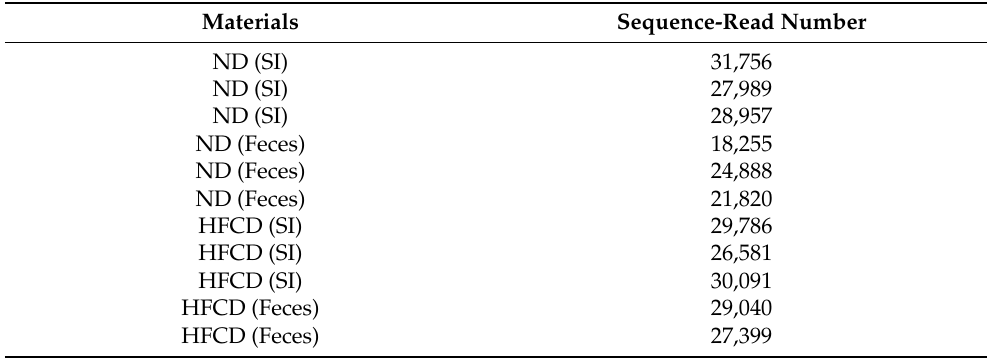
Table 2. Sequence-read number of the V4–V5 region of the 16S rRNA from bacteria of small intestines (SIs) and feces in stroke-prone spontaneously hypertensive-5 (SHRSP5) rats fed normal diet (ND) or high-fat- and high-cholesterol-containing diet (HFCD) on the lllumina MiSeq